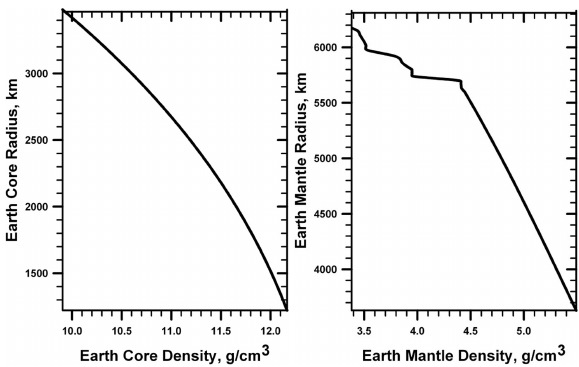
Figure 6. Earth-core and Earth-mantle density as a function of ra- dius. Data from Dziewonski and Anderson (1981) and Dziewonski and Gilbert